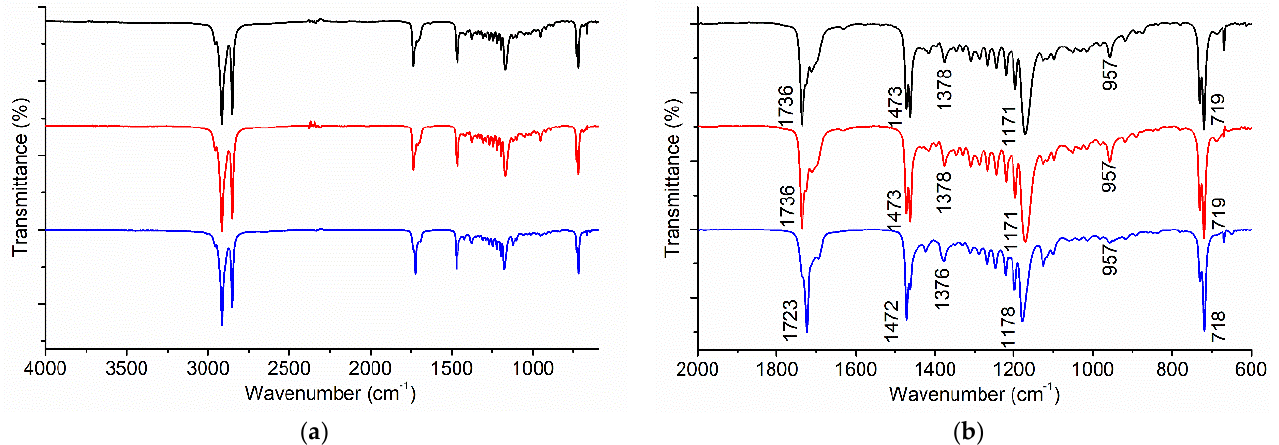
Figure 5. FTIR spectra of adhesive 1 (black), adhesive 2 (red), and commercial beeswax (blue): ( a ) Full spectra; ( b ) Region from 2000 cm −1 to 600 cm −1 .